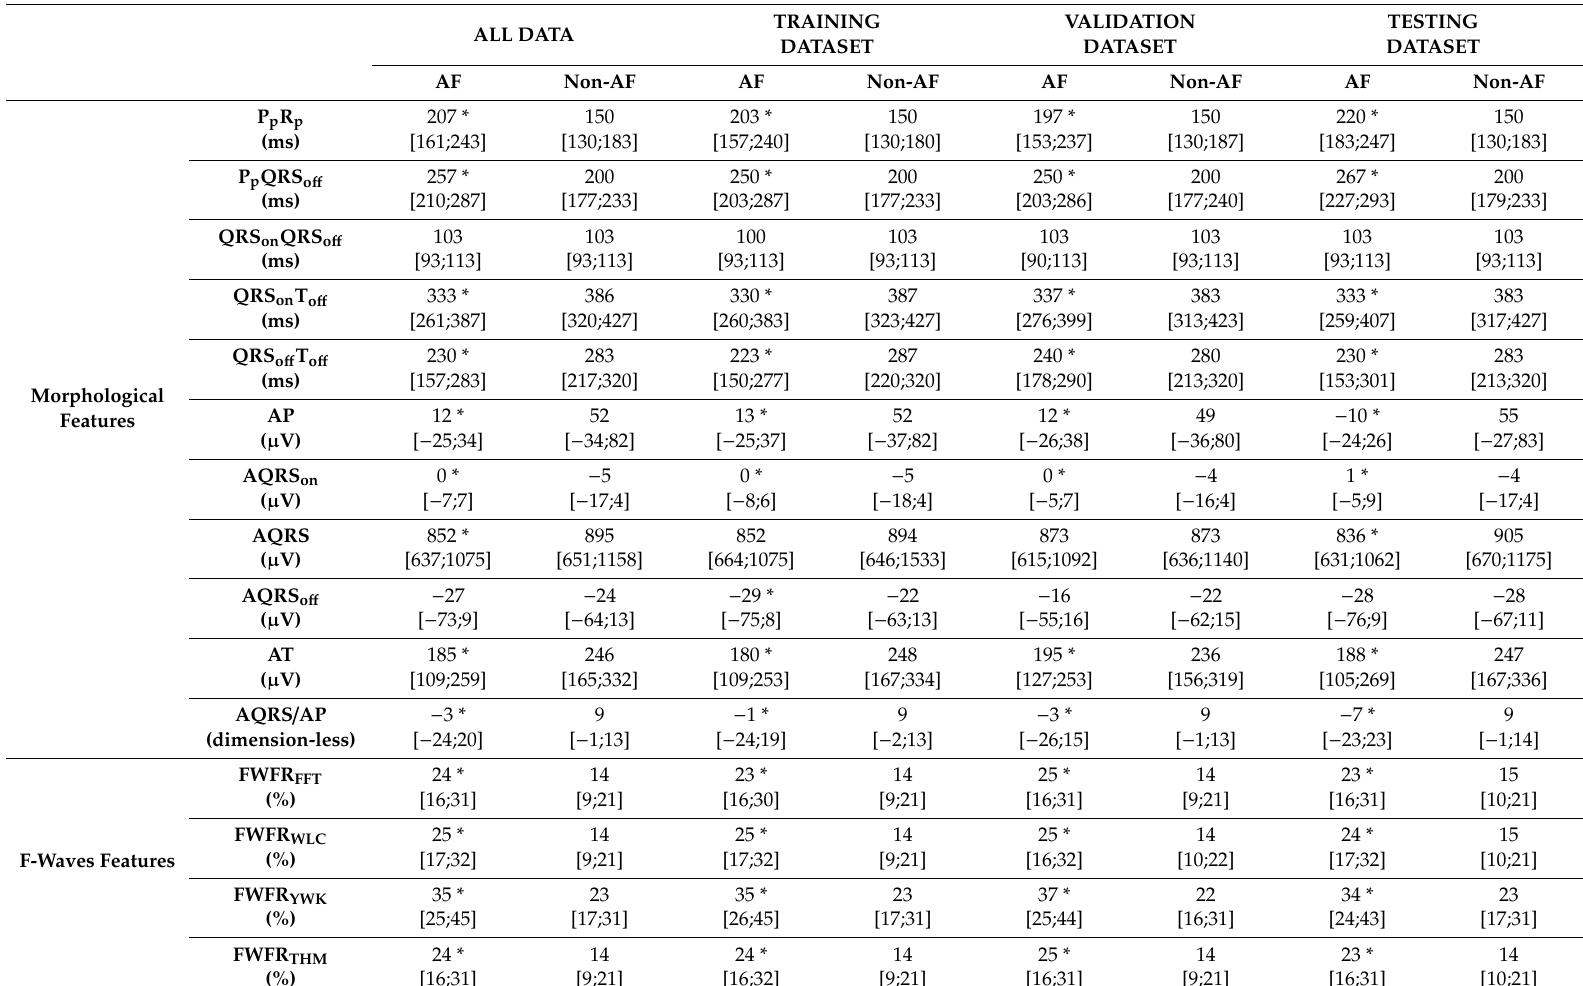
Table 3. Feature distributions of both AF and non-AF of all data, training, validation and testing